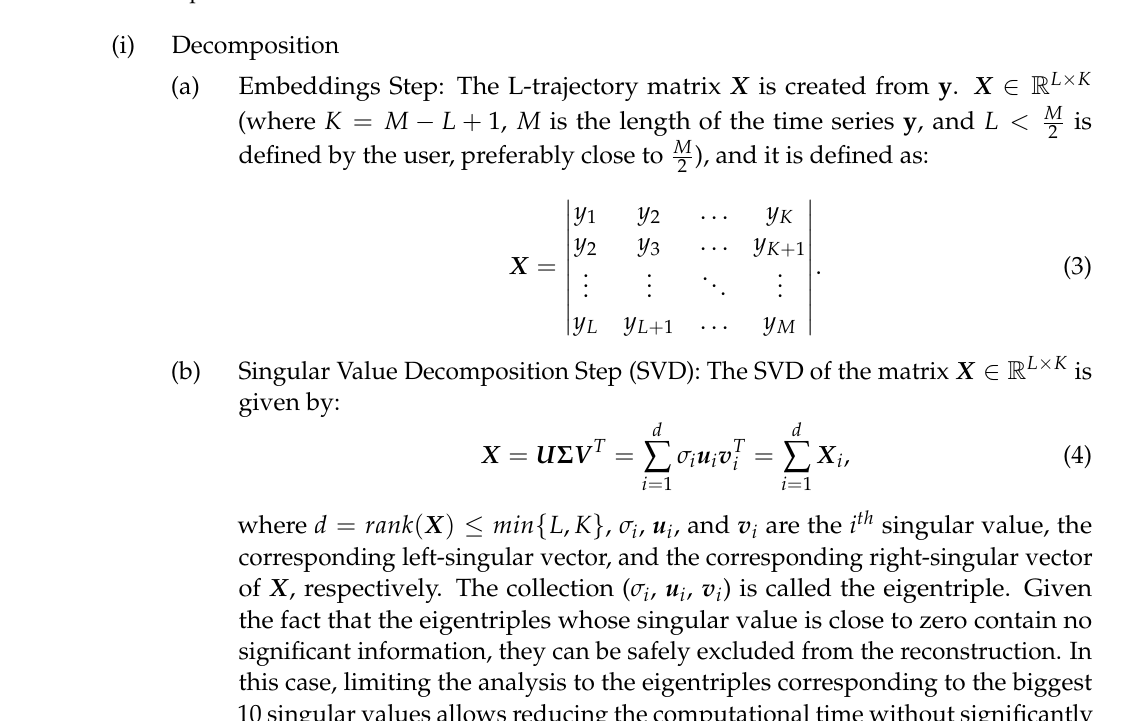
Figure 4. Decomposition of a PPG signal by means of singular spectrum analysis into five additive